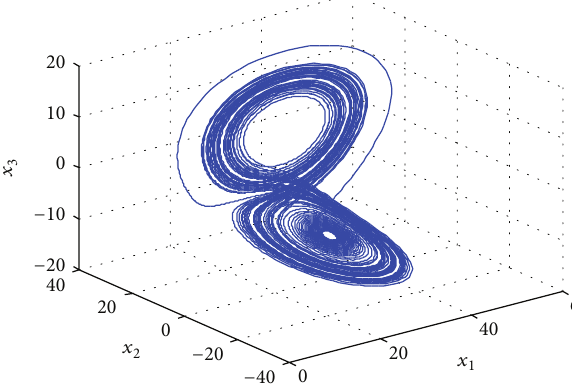
Figure 1: The chaotic orbit of the Lorenz system.